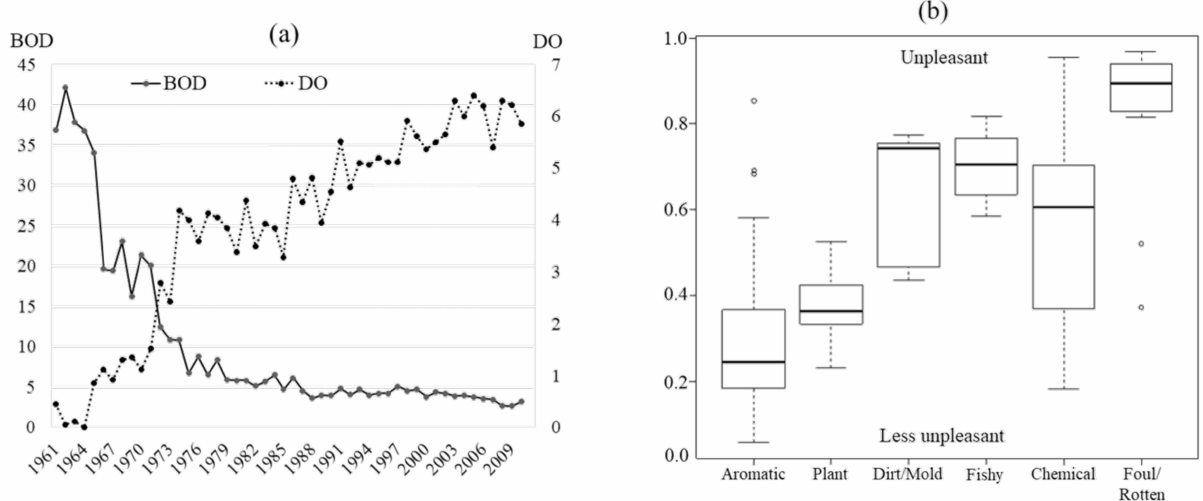
Figure 2. ( a ) BOD concentration (mg L − 1 ) and DO (mg L − 1 ) of the Sumida River. ( b ) Hedonic tones of odor for the six types categorized by the TMG. Aggregated mean: aromatic = 0.29, plant = 0.37, dirt/mold = 0.64, fishy = 0.70, chemical = 0.56, foul/rotten =